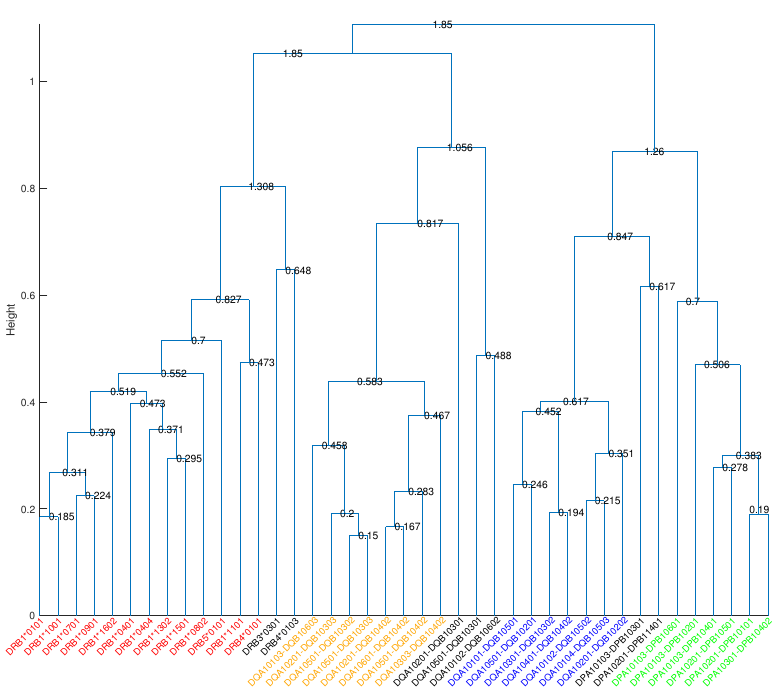
Figure 1. Cluster tree on 41 class II HLA molecules. The height of each horizontal line corresponds to the distance between the two clusters it merges. The numbers given in the figure are the diameters of the corresponding unions of clusters. Four main clusters, main DR, main DQ1, main DQ2, and main DP, are highlighted in red, orange, blue, and green,